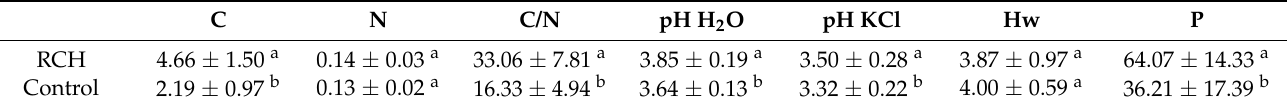
Table 3. C, N and P content and acidity of charcoal hearth horizon (RCH) and control soil (experiment 2).